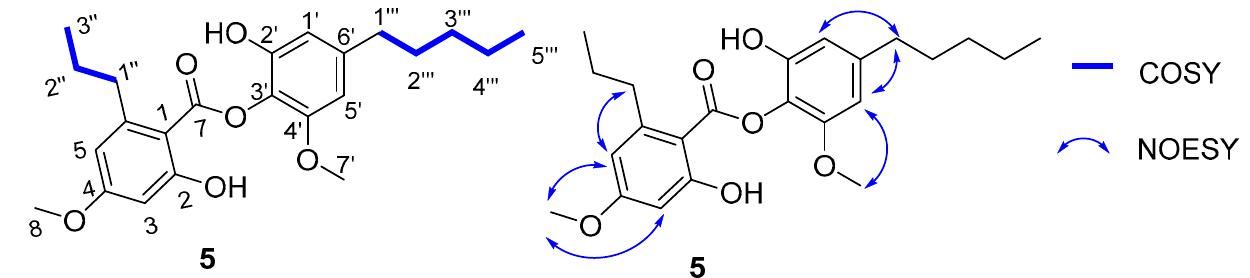
Molecules 2022 , 27 , x FOR PEER REVIEW